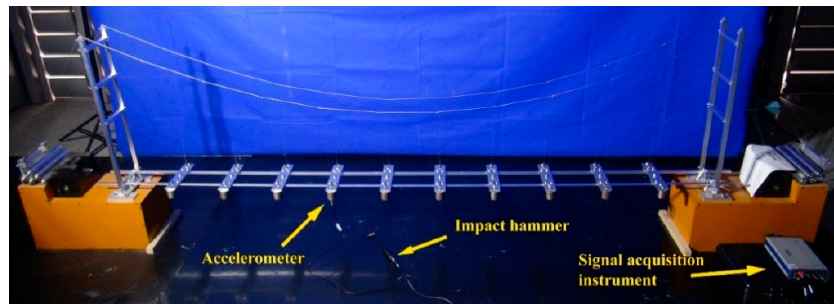
Figure 13. Mode shapes of TMD2. ( a ) The 1st mode; ( b ) the 2nd mode. Table 5. Calculation results of 2DOFs TMDs.